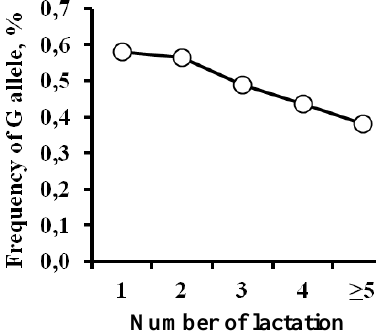
Figure 1. Temporal changes of the G allele frequency of the TNF  -824A/G polymorphism per number of lactations in Black Pied cattle which is likely due to differential culling of herd. n = 31-107 animals per point. Significant differences in the G allele frequencies were observed between the first and fourth lactations ( x 2 = 4.02, p<0.045) and between the first lactation and combining data for fifth and following lactations ( x 2 = 10.85, p<0.02) as well. The G allele frequency was negatively correlated with number of lactation (r s = -0.99,